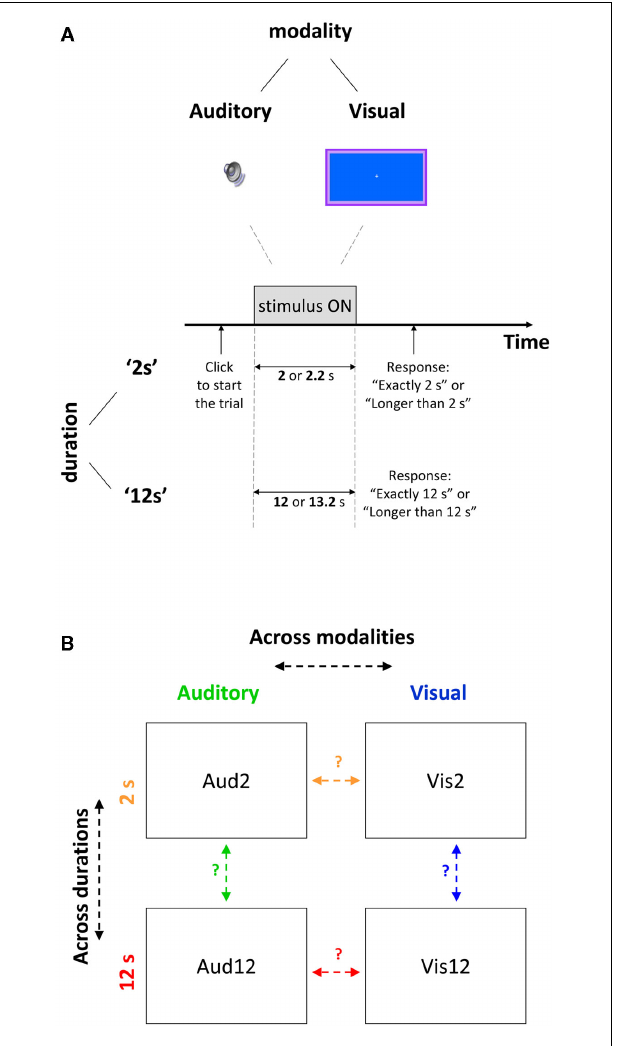
FIGURE 1 | Experimental design (A) Depiction of a duration discrimination trial, presented either visually or aurally for shorter (2s) or longer (12s) durations. Trials were blocked by condition and lasted for target duration (2 or 12s respectively) or 10% longer.To begin each trial participants had to press a key. After stimulus offset participants had to indicate via button press whether target or non-target duration was presented in a 2AFC manner. (B) Predictions for common neural mechanisms across different modalities (orange arrow for shorter duration, red for longer duration) or for different durations (green for auditory, blue for visual) based on correlation strengths of the variability in time estimation.